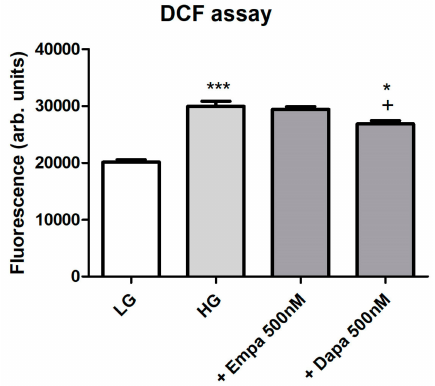
Figure 5. Formation of oxidative stress under diabetic culture conditions. Confluent PTCs in 96-well plateswereculturedinLG,HGorwithgliflozins(500nM)for6d. Then, 2 (cid:48) ,7 (cid:48) -dichlorodihydrofluorescein diacetate (20 µ M in Hank’s bu ff ered saline solution) was added for 30 min at 37 ◦ C. Fluorescence of intracellular DCF was measured using a fluorescence reader with excitation and emission wavelengths of 485 and 538 nm (arbitrary units, mean ± SD, n = 6, *** p < 0.001 vs. LG, + p < 0.05 vs. HG, * p < 0.05 vs. Empa 500